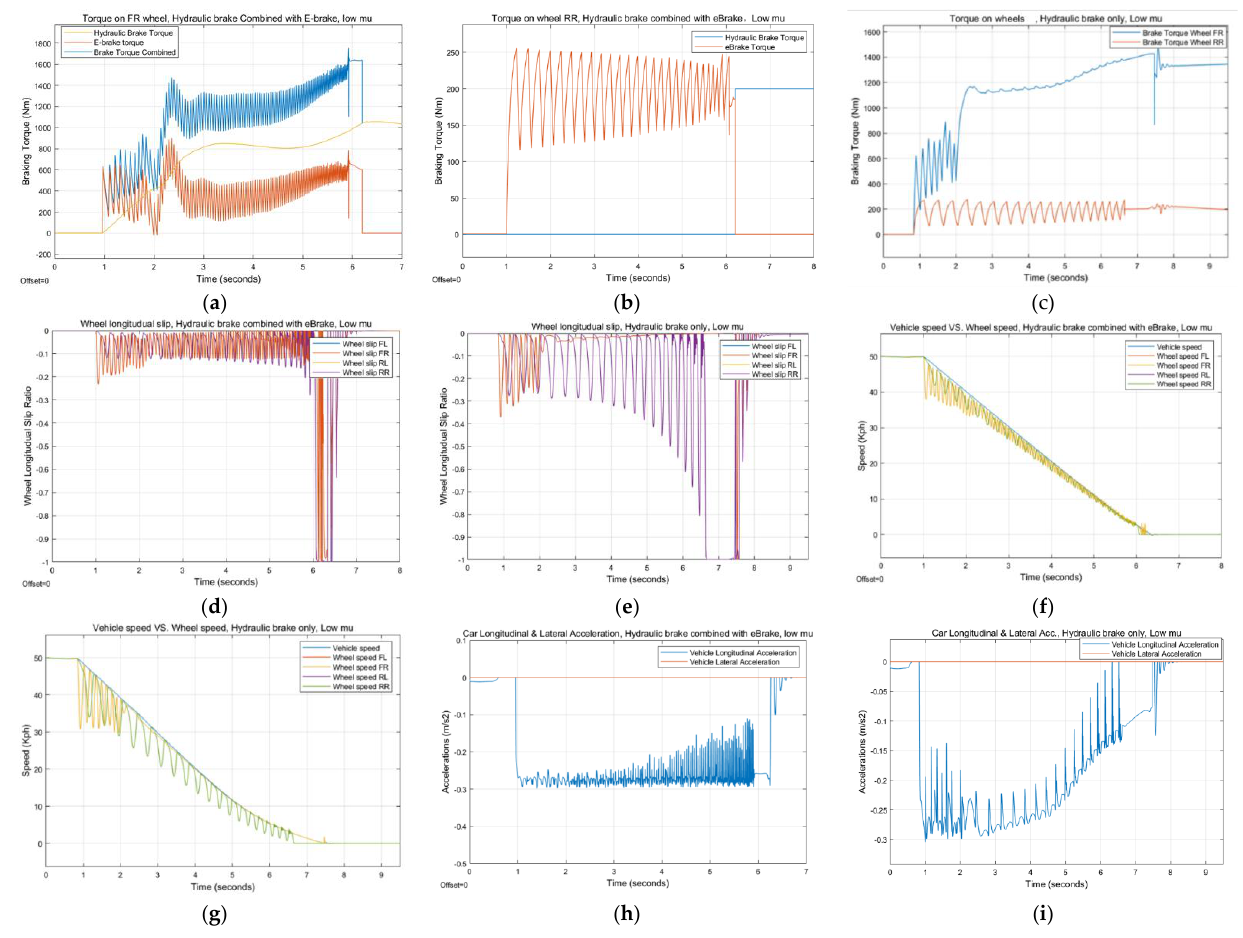
Figure 10. Simulation results for AEBS control strategy validation in low 𝜇 road. ( 𝜇 = 0.3 ) ( a ) Total braking torque, torque from RBS and HBS on wheel FR of ego vehicle; ( b ) RBS and HBS torque on wheel RR of ego vehicle; ( c ) HBS torque on wheel FR and wheel RR of ego vehicle; ( d ) longitudinal slip ratio of ego vehicle wheels, RBS+HBS; ( e ) longitudinal slip ratio of ego vehicle wheels, HBS only; ( f ) ego vehicle speed vs. wheel speed, RBS+HBS; ( g ) ego vehicle speed vs. wheel speed, HBS only; ( h ) longitudinal and lateral acceleration of ego vehicle, RBS+HBS; ( i ) longitudinal and lateral acceleration of ego vehicle, HBS only.